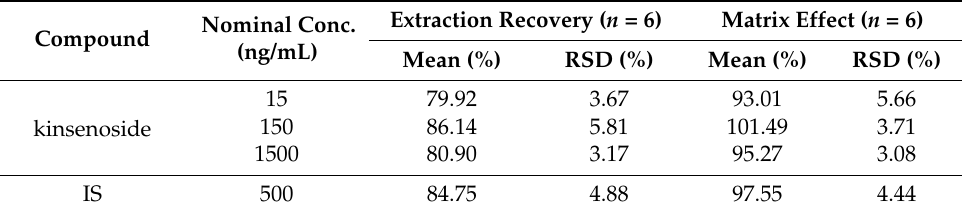
Table 2. The recovery and matrix effect of kinsenoside and internal standard.